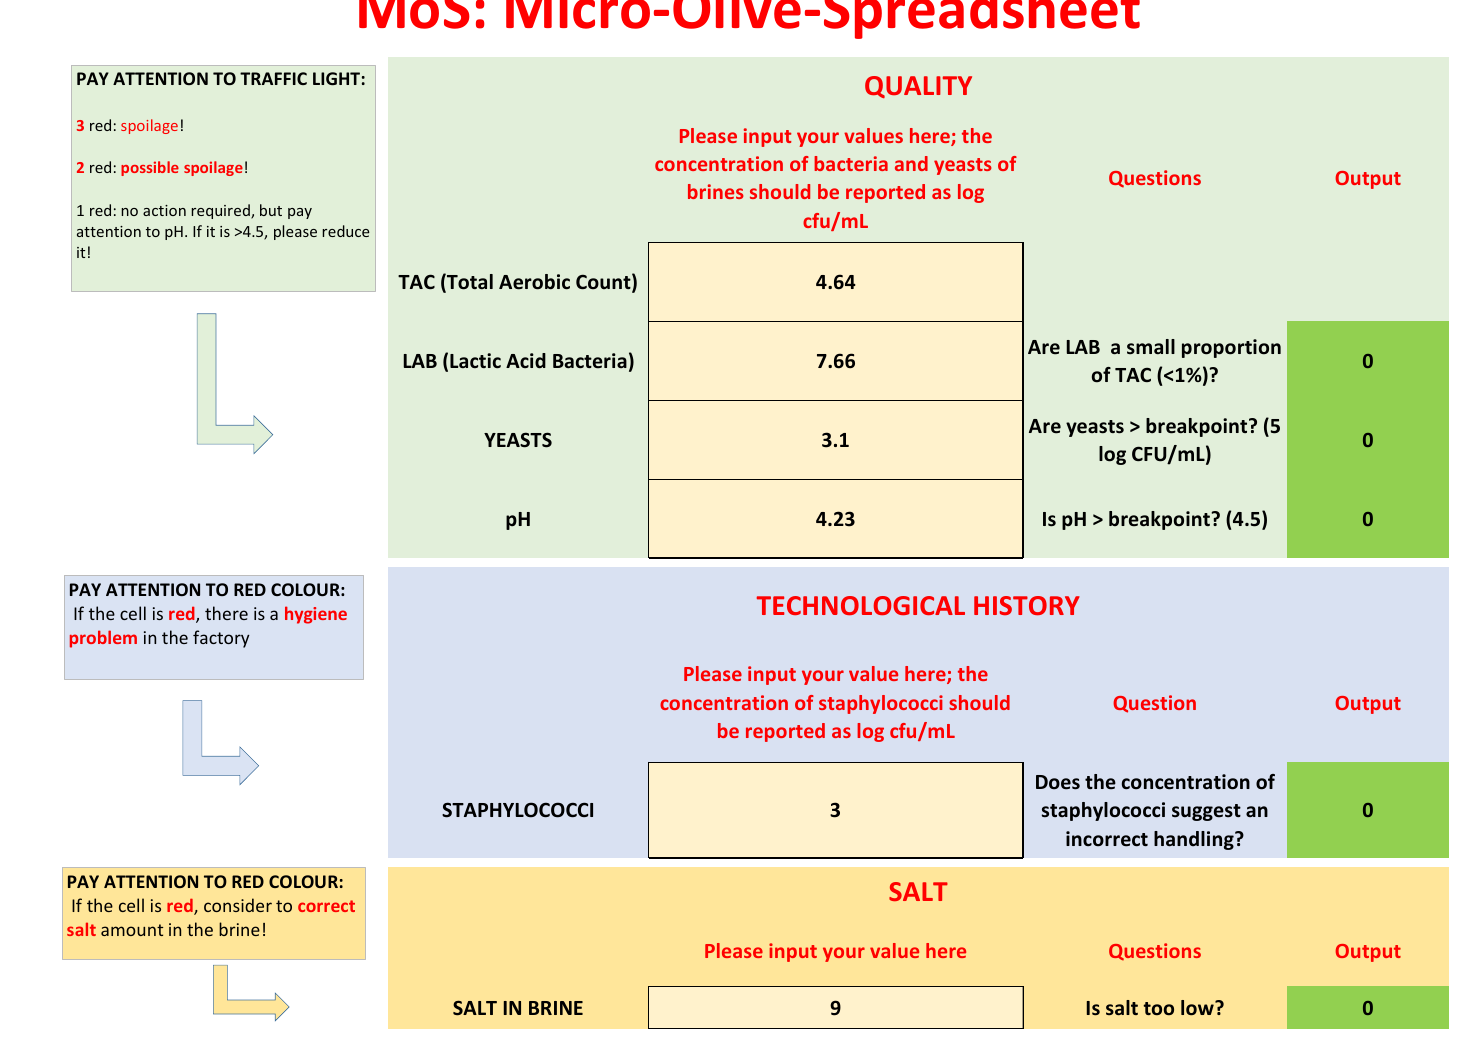
Figure 2. Input and Output of MoS.